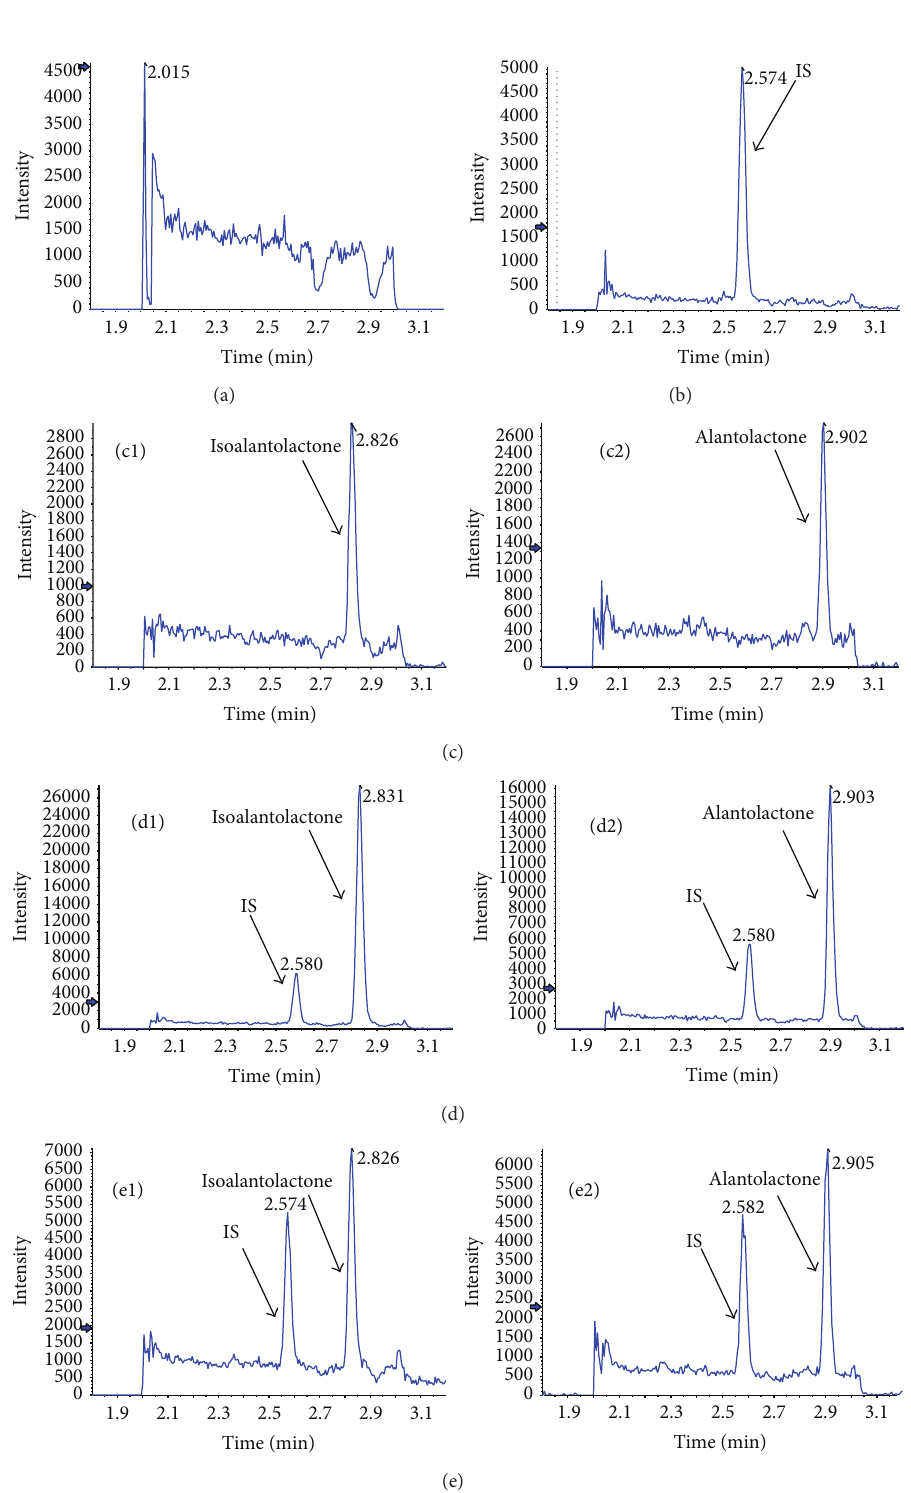
Figure 2: Representative multiple reaction monitoring chromatograms of (a) a blank plasma sample of rats, (b) a blank rat plasma sample spiked with IS (0.1ng/mL), (c) a blank rat plasma sample spiked with lactones ((c1) for isoalantolactone at 2.5 ng/mL and (c2) for alantolactone at 4 ng/mL), (d) acetonitrile spiked with IS and lactones ((d1) for isoalantolactone and (d2) for alantolactone), and (e) a rat plasma sample obtained 2 h after intravenous injection of 5 mg/kg isoalantolactone (e1) and 4 h of alantolactone